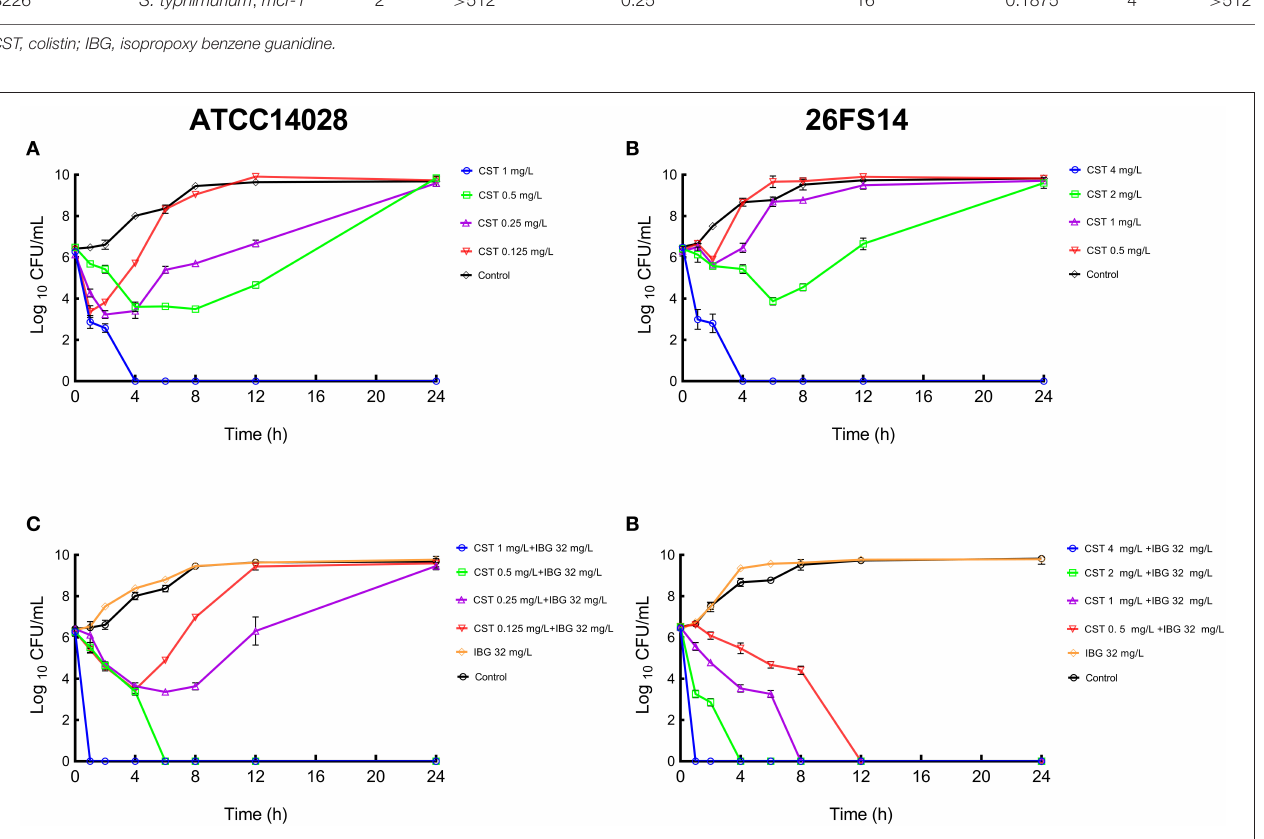
bacterial count (CFU/mL) was determined for each tube after 0, 1, 2, 4, 6, 8, 12, and 24 h of incubation. In brief, 100 µ L of culture was obtained for each time point, and serially diluted, and the colonies were counted the next morning. Each concentration test was performed in